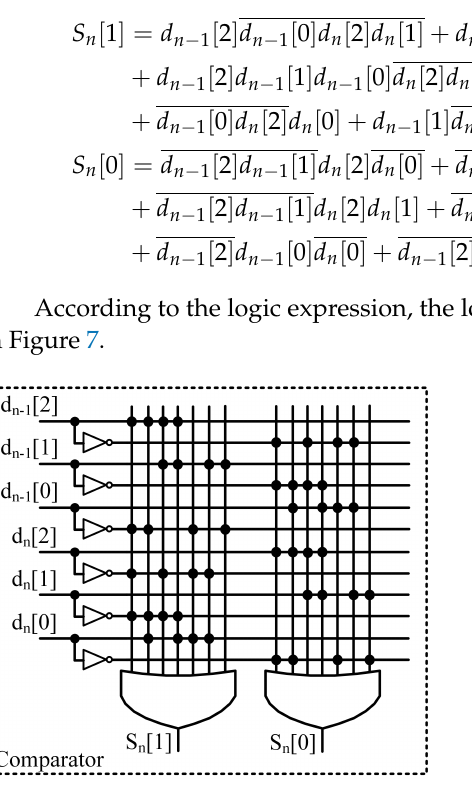
Figure 7. Logic gate circuit of Comparator.